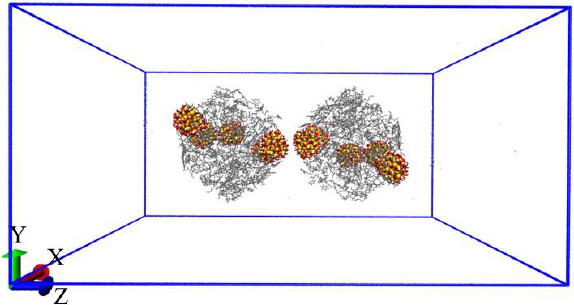
Figure 3. Lateral view of model simulation of oil droplets in O/W emulsion. For clarity, water molecules in the system are not shown.